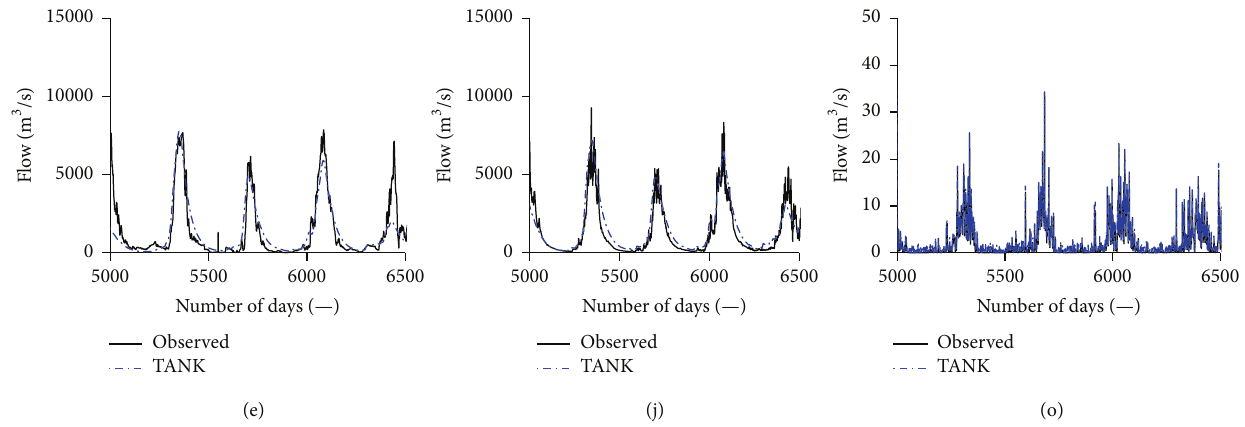
Figure 4: Observed and modeled daily flows at (a)–(e) Khartoum, (f)–(j) El Diem, and (k)–(o) Ribb based on (a, f, k) AWBM, (b, g, l) IHACRES, (c, h, m) SAC, (d, i, n) SIMHYD, and (e, j, o) TANK. The number of days from 5000 to 6500 in the horizontal axis covers the period of flows from 9/8/1993 to 17/10/1997.